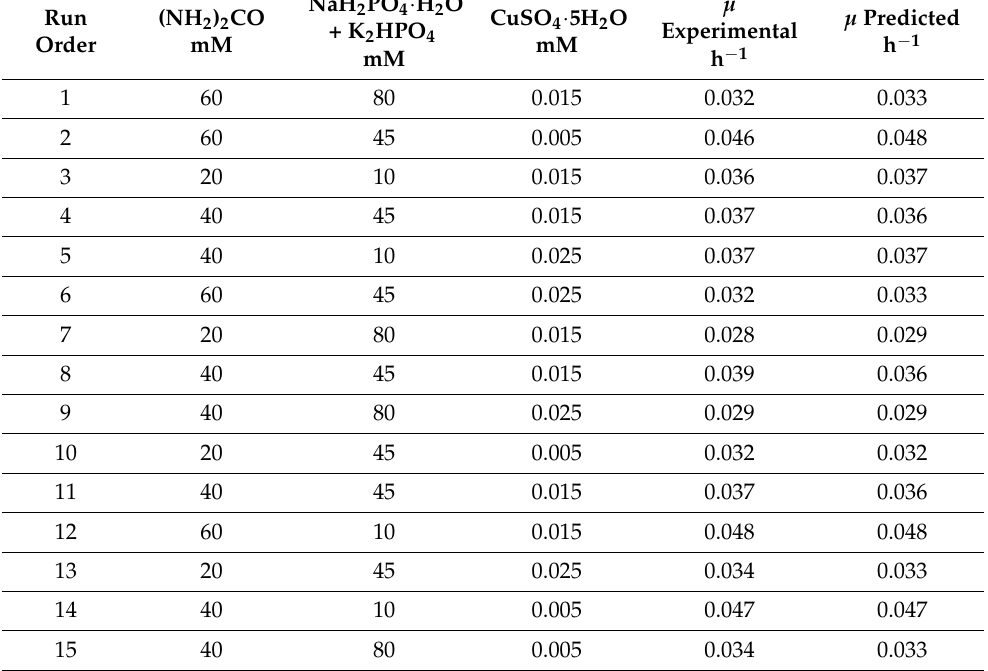
Table 2. Experimental layout of Box–Behnken design; the experimental and predicted results of the specific growth rates ( µ ) of heterotrophic